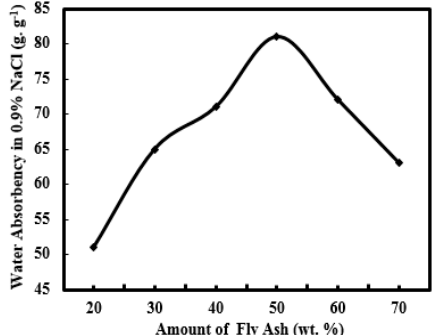
Figure 5. Effect of FA amount in PAA-AM/FA on water absorbency in 0.9% NaCl aqueous solution (polymerization temperature, 70 °C; mass ratio of AA/AM, 1.5; neutralization degree of AA, 70%; crosslinker concentration, 0.7%).